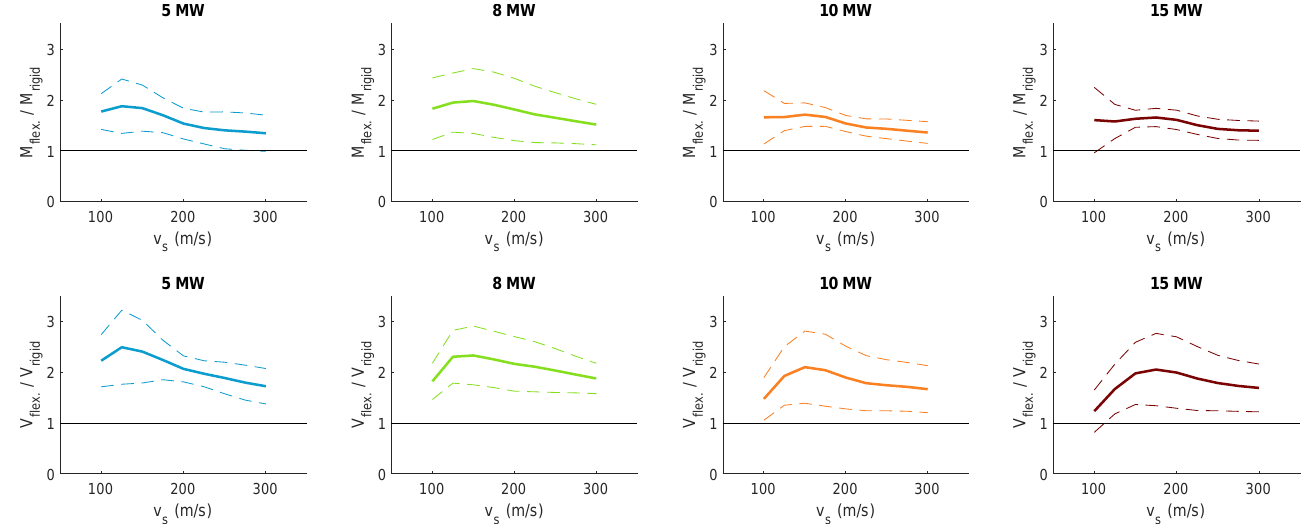
Figure 5. Ratio between the maximum seismic bending moment and shear force at mudline level under the flexible and rigid base assumption. Mean value (solid line) and dispersion (dashed lines) of the results corresponding to different